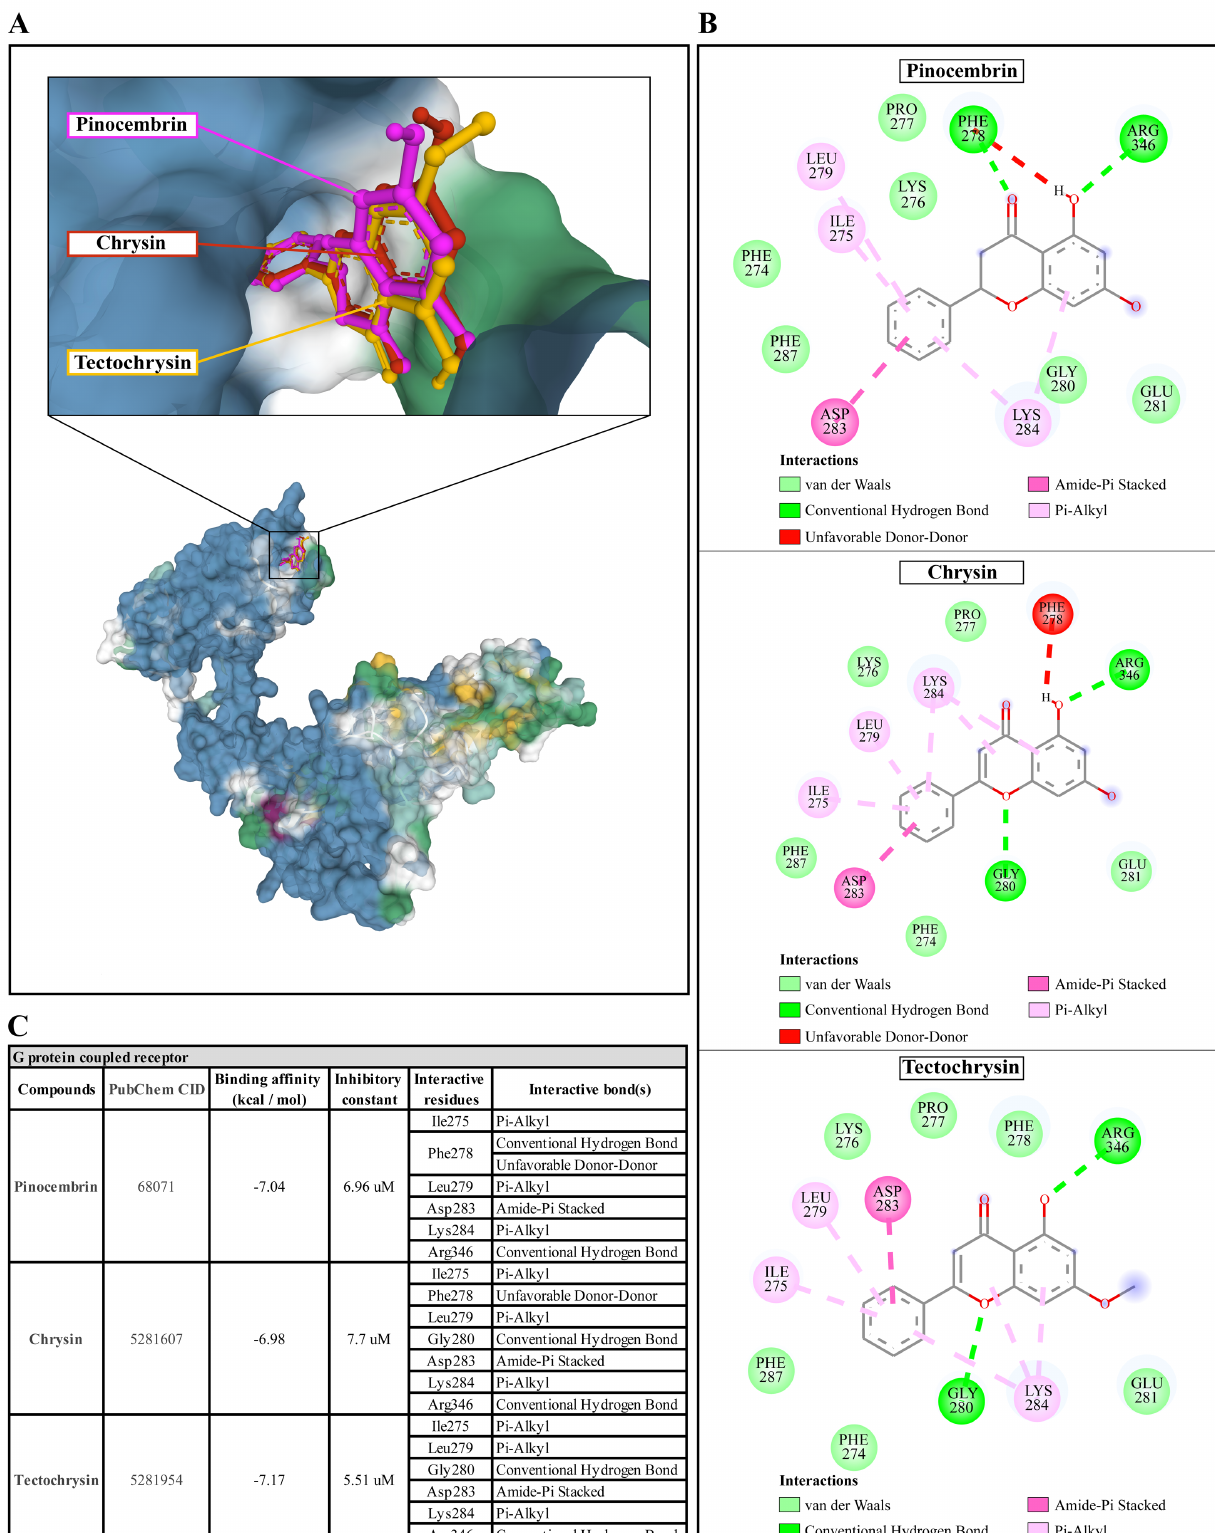
Figure 6. The interaction of pinocembrin, chrysin, and tectochrysin toward the AcGPCR protein predicted by molecular docking. ( A ) Binding site of the ligands toward the AcSIR2 protein, purple compound represents Pinocembrin, red compound represents Chrysin, yellow compound represents Tectochrysin. ( B ) A schematic representation of the detailed interactions of the ligand atoms with the protein residues. ( C ) Binding affinity and inhibitory constant prediction of propolis compounds against G protein-coupled receptor of Acanthamoeba castellanii . AcGPCR, A. castellanii G protein-coupled receptor; AcSIR2, A. castellanii Sir2 family protein.